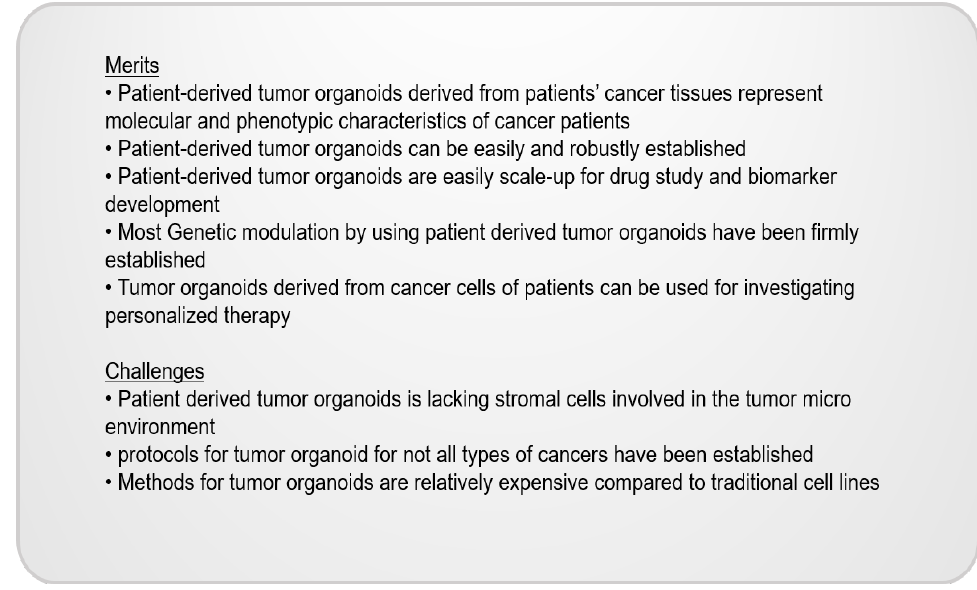
Figure 2. The benefits and limitations of organoid systems.